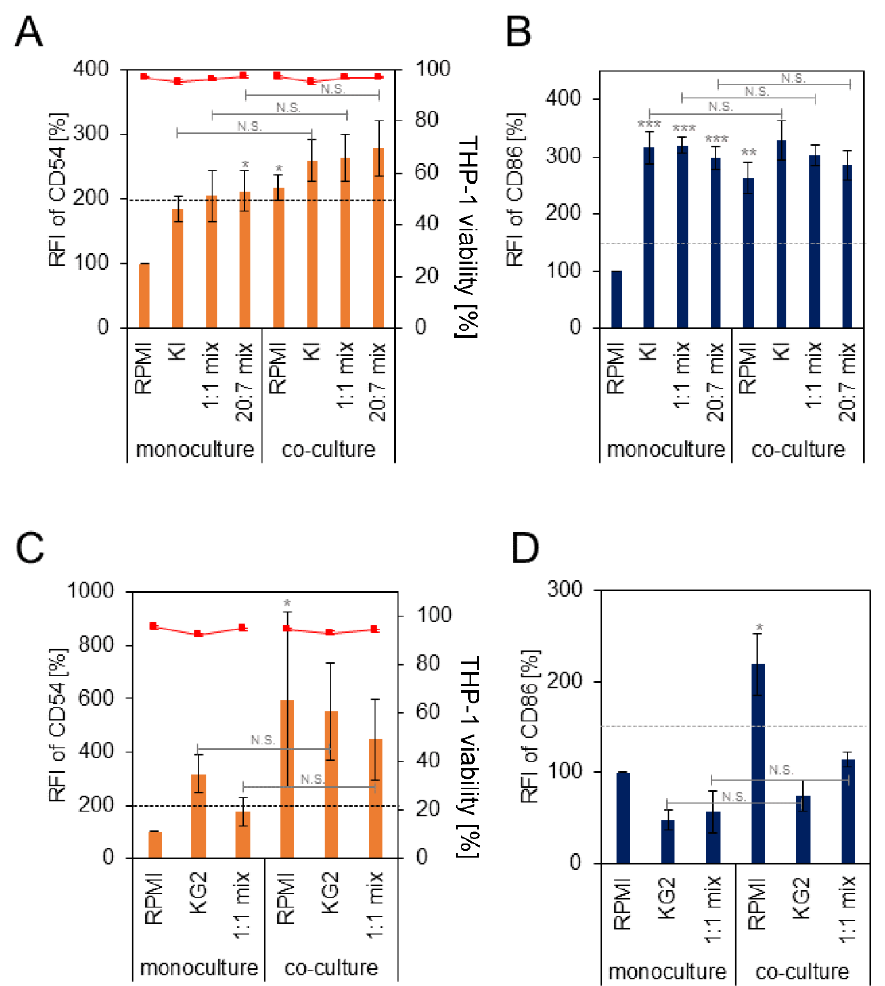
Figure 5. The expression levels of CD54 and CD86 on THP-1 cells were increased by changing the medium or co-culturing with NHEK compared to the single culture. The effect of medium on cell viability and basal CD54 and CD86 expression of mono-cultured and co-cultured THP-1 cells. Cell viability and expression levels of CD54 ( A , C ) and CD86 ( B , D ) on THP-1 mono-cultured or co-cultured with keratinized NHEK cells (A,B) and undifferentiated NHEK cells ( C , D ) in various kinds of medium were analyzed using flow cytometry (mean ± SD, n = 3). RFI, relative fluorescence intensity; KG2, normal human epidermal keratinocyte growth medium supplemented with a set of growth additives, KI, keratinization induction medium; 20:7 mix, mixing ratio was RPMI:KI = 20:7. *, **, ***: Statistically significant from control (monoculture RPMI) or between indicated sample pair by Dunnett’s post-hoc test. * p < 0.05. ** p < 0.01. *** p < 0.005. N.S.: not significant. The black (left) and gray (right) dashed lines visually indicate the positive criteria for skin sensitization in h-CLAT for CD54 and CD86, respectively (CD54 ≥ 200%, CD86 ≥ 150%).